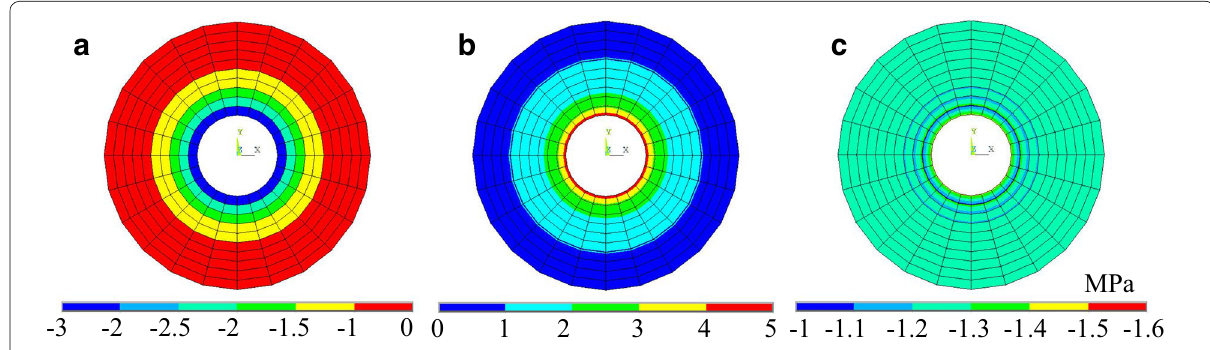
Fig. 7 Stress contours in the pile: a σ r , S